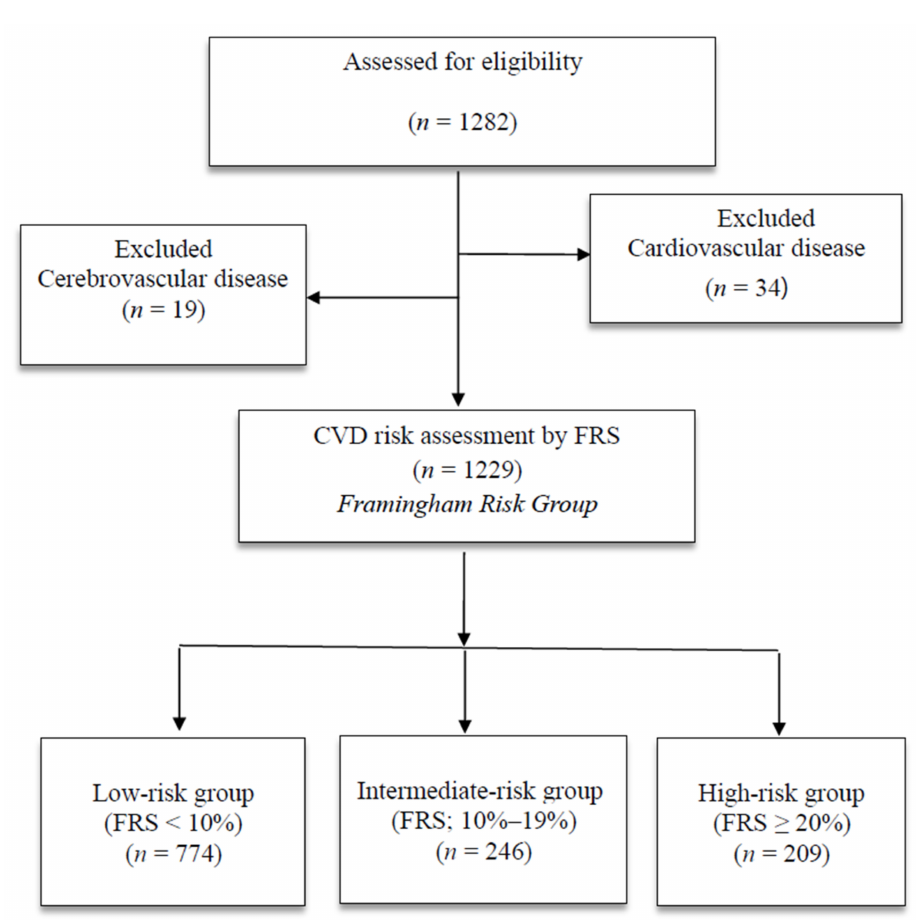
Figure 1. Flow chart of the study population; HDL = high-density